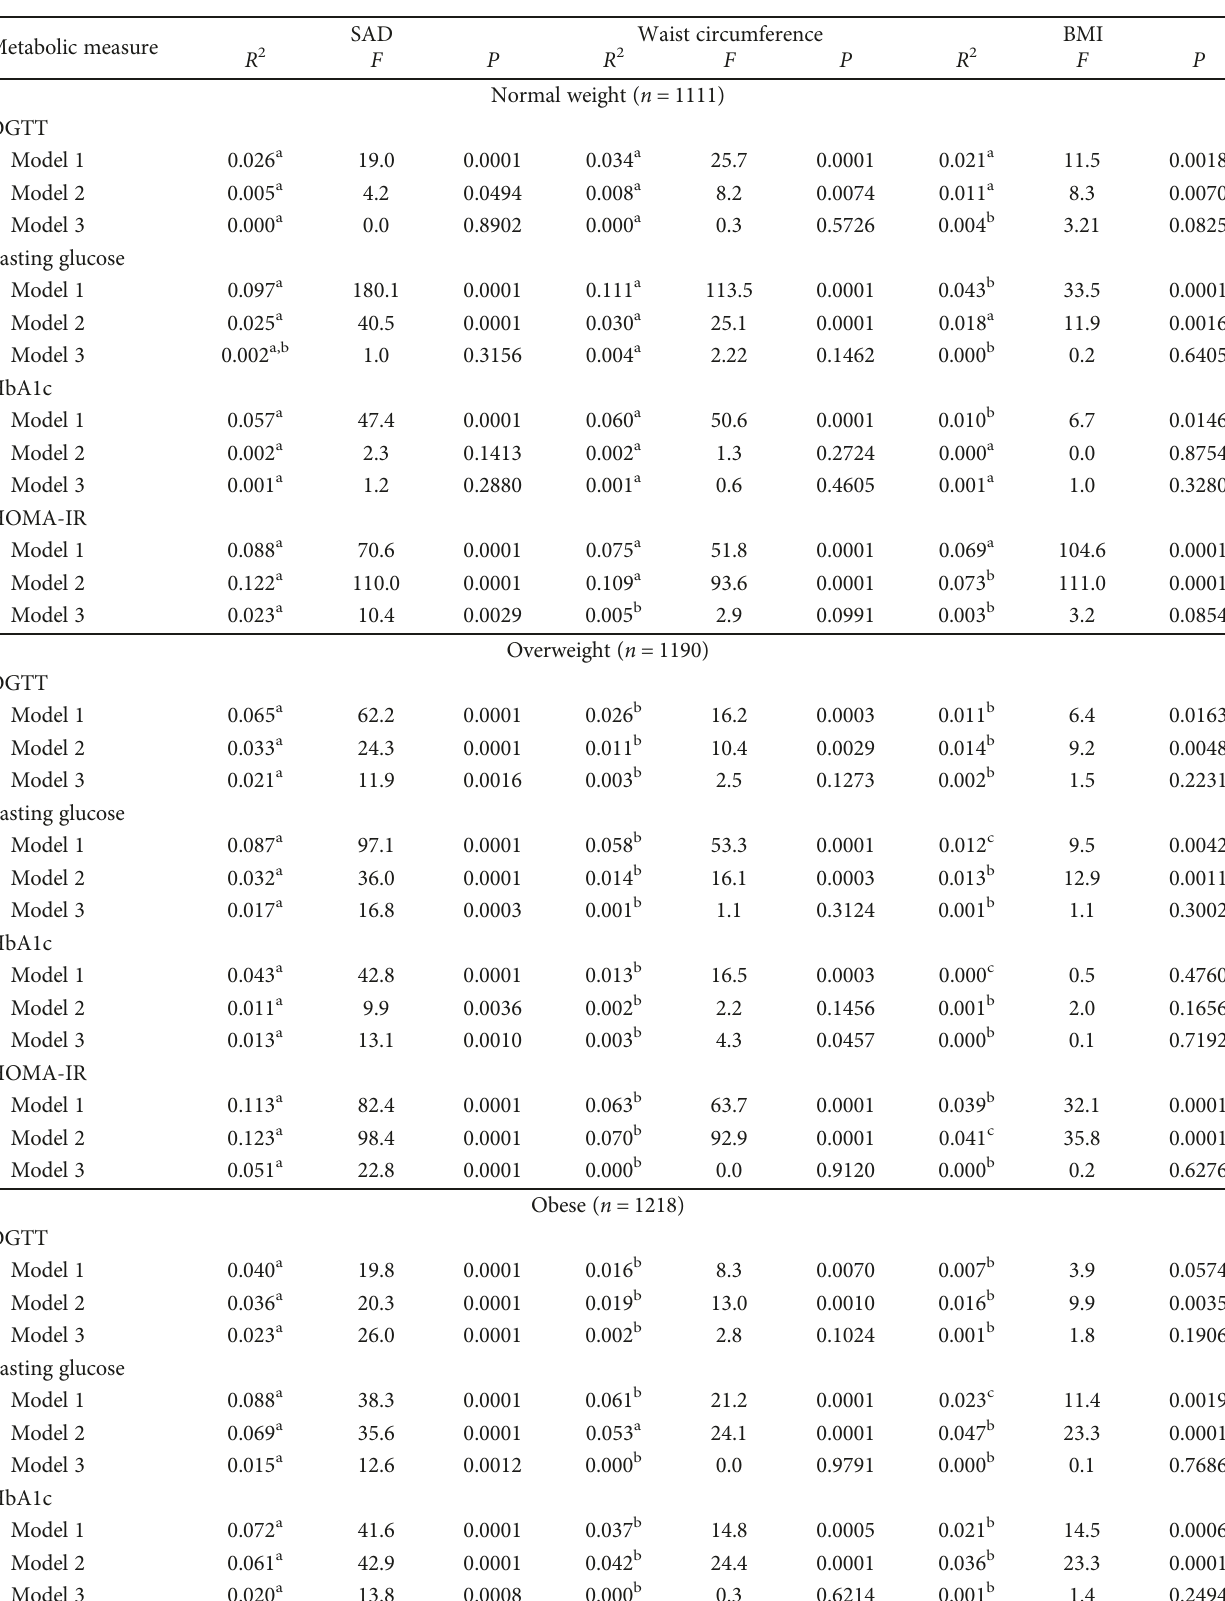
Table 4: Shared variance between the anthropometric variables and the glucose metabolism variables by BMI category. Metabolic